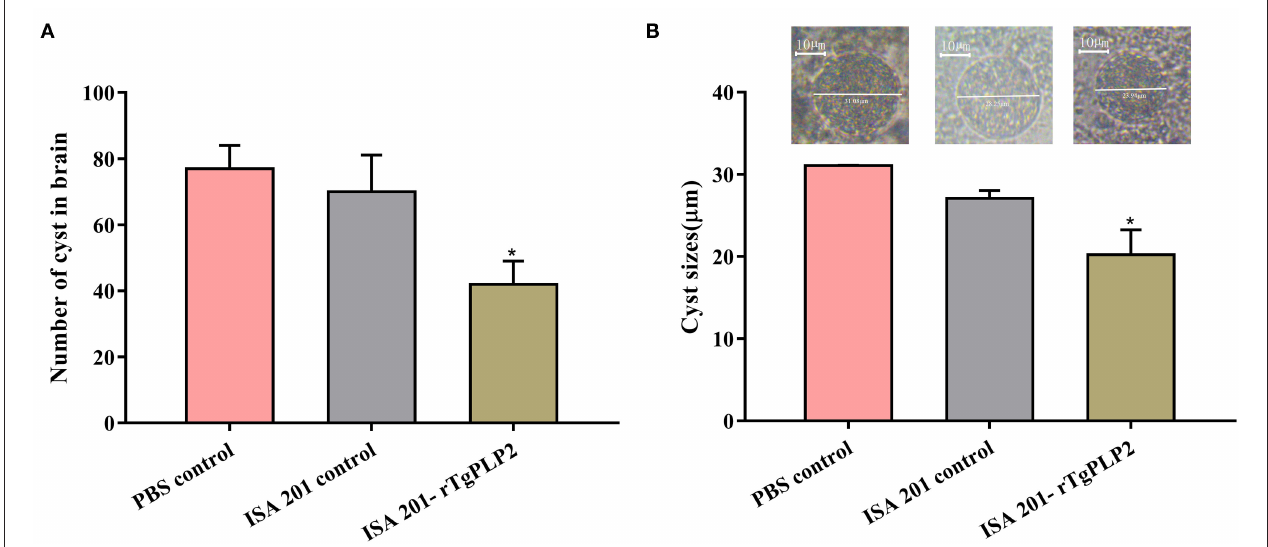
FIGURE 8 | Number (A) and size (B) of brain cysts in the mice infected with T. gondii PRU strain. Data were expressed as mean ± SEM. * p < 0.05 compared with PBS controls.